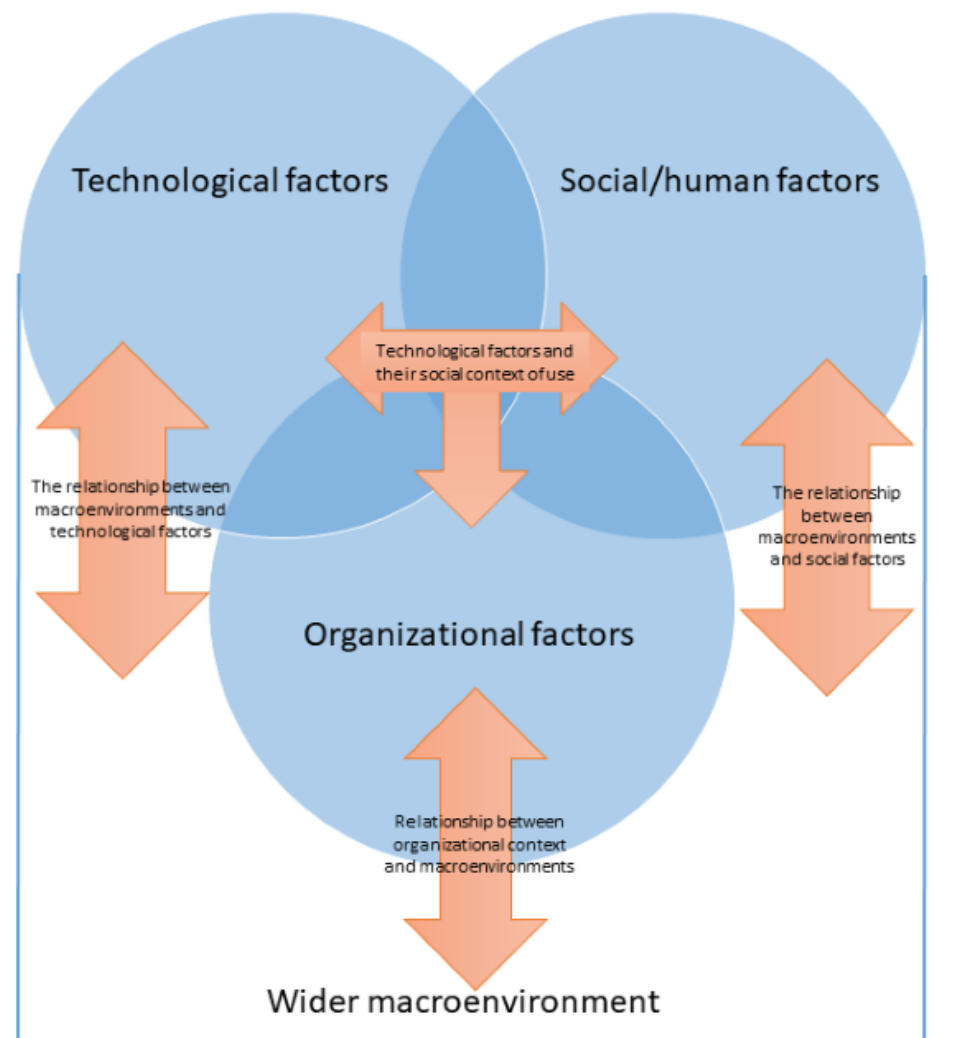
Figure 1. Diagram illustrating the evaluation